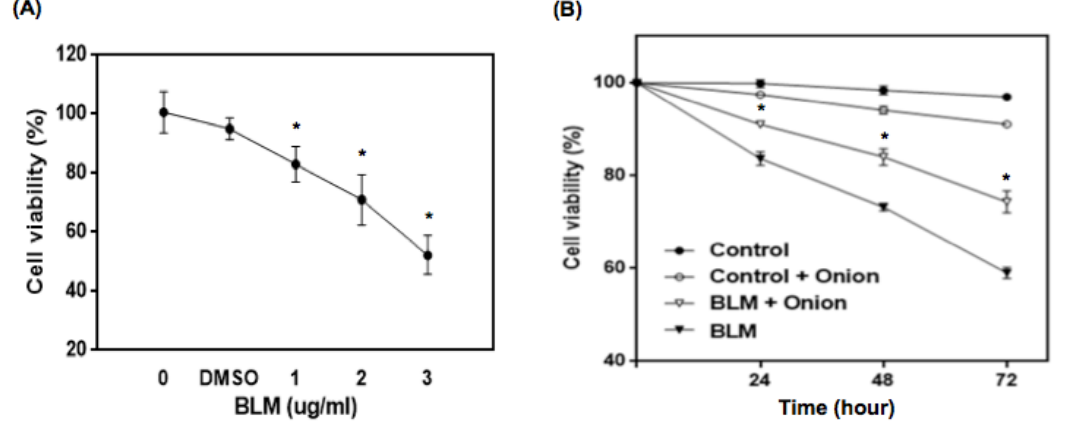
Figure 1. Influence of BLM on the viability of human PBMCs as measured by the trypan blue exclusion method. ( A ) Human PBMCs were treated with the indicated concentrations of BLM for 24 hours. A significant decrease in the number of trypan blue-negative cells was evident in the BLM-treated lymphocytes. * p < 0.01 compared to untreated controls; ( B ) Lymphocytes were treated with or without 20 μ L/mL of onion extract and 1 μ g/mL of BLM. A significant increase in the number of trypan blue-negative cells was evident in the cells treated with onion extract compared to the cells treated with BLM only. The data shown represent means ± SD of three different experiments. * p < 0.05 compared to the cells treated with BLM only. Table 1. The effect of onion extract on BLM-induced micronuclei frequency in human lymphocytes. Multi MNCB b /MNCB Treatment No. of MNCB a Cells/2000 BN Cells No. of MNCB Treatment